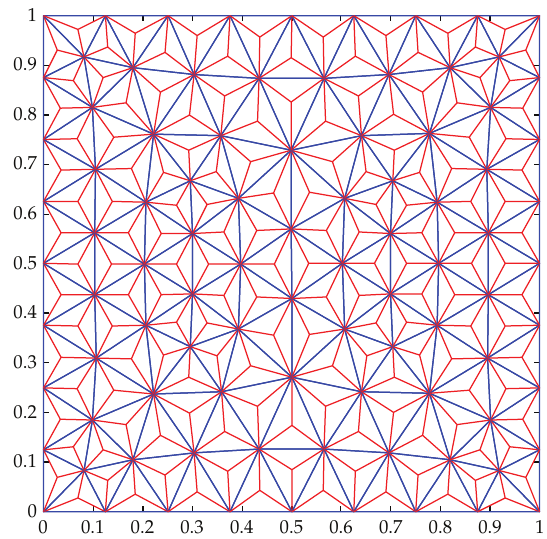
Figure 5: Triangular and its dual partition of (cid:4) 0 , 1 (cid:6) × (cid:4) 0 , 1 (cid:6)